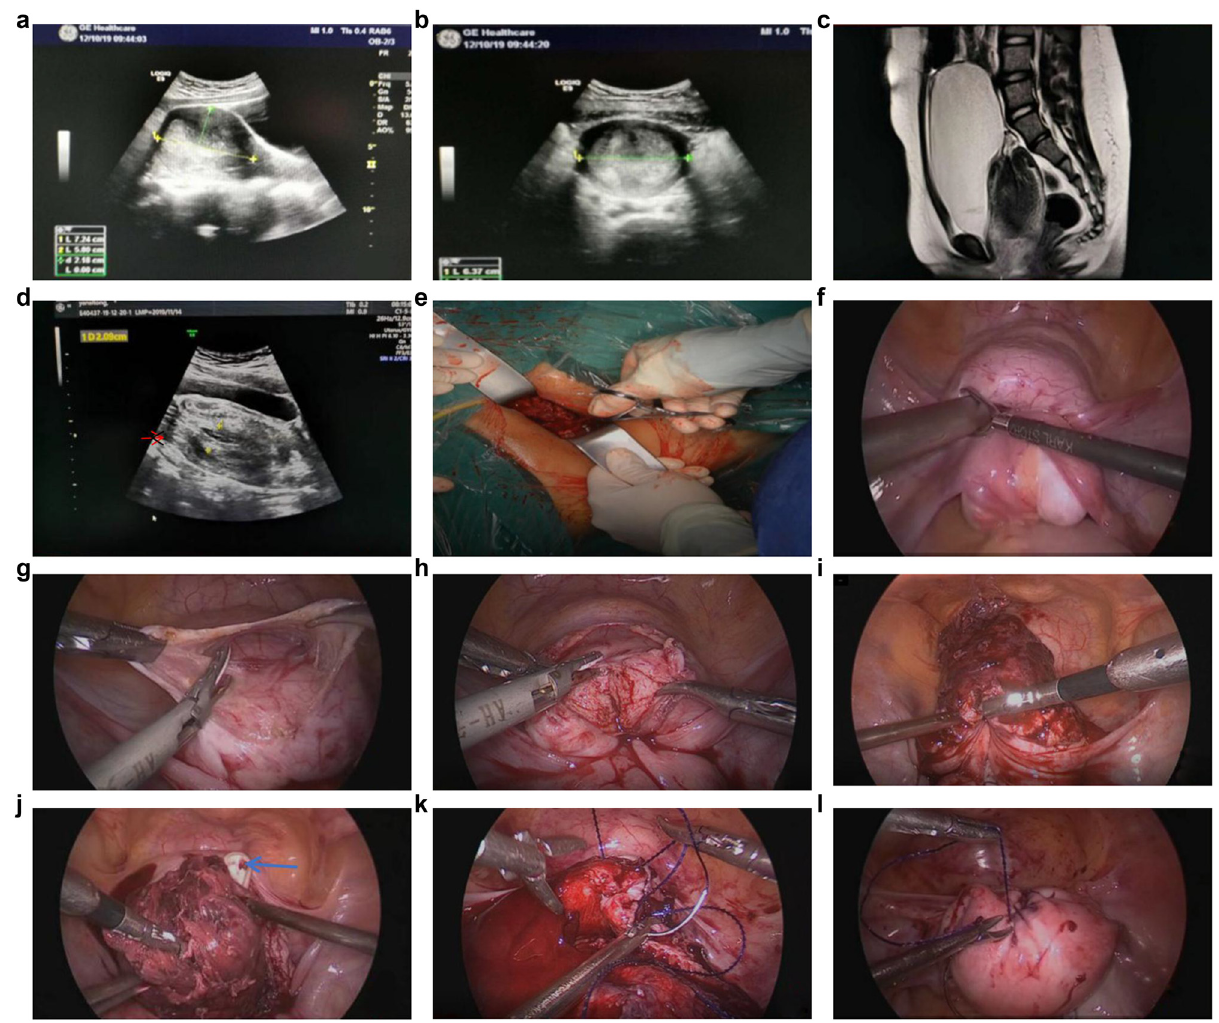
Figure 1: ( a and b ) Color ultrasound images ( sagittal and transverse position ) 10 days before the surgery. ( c ) MRI image after admission. ( d ) Color ultrasound image after admission ( the arrow points to the ovary ) . ( e ) Intraoperative vaginal view. ( f ) Intraoperative laparoscopic view. ( g ) The uterine serosa was incised. ( h ) The anterior myometrium and the vagina were incised. ( i and j ) Uterus after incision ( the blue arrow indicates the fi nger of the vaginal operator ) . ( k ) Suturing the vagina and the myometrium. ( l ) Uterus at the end of